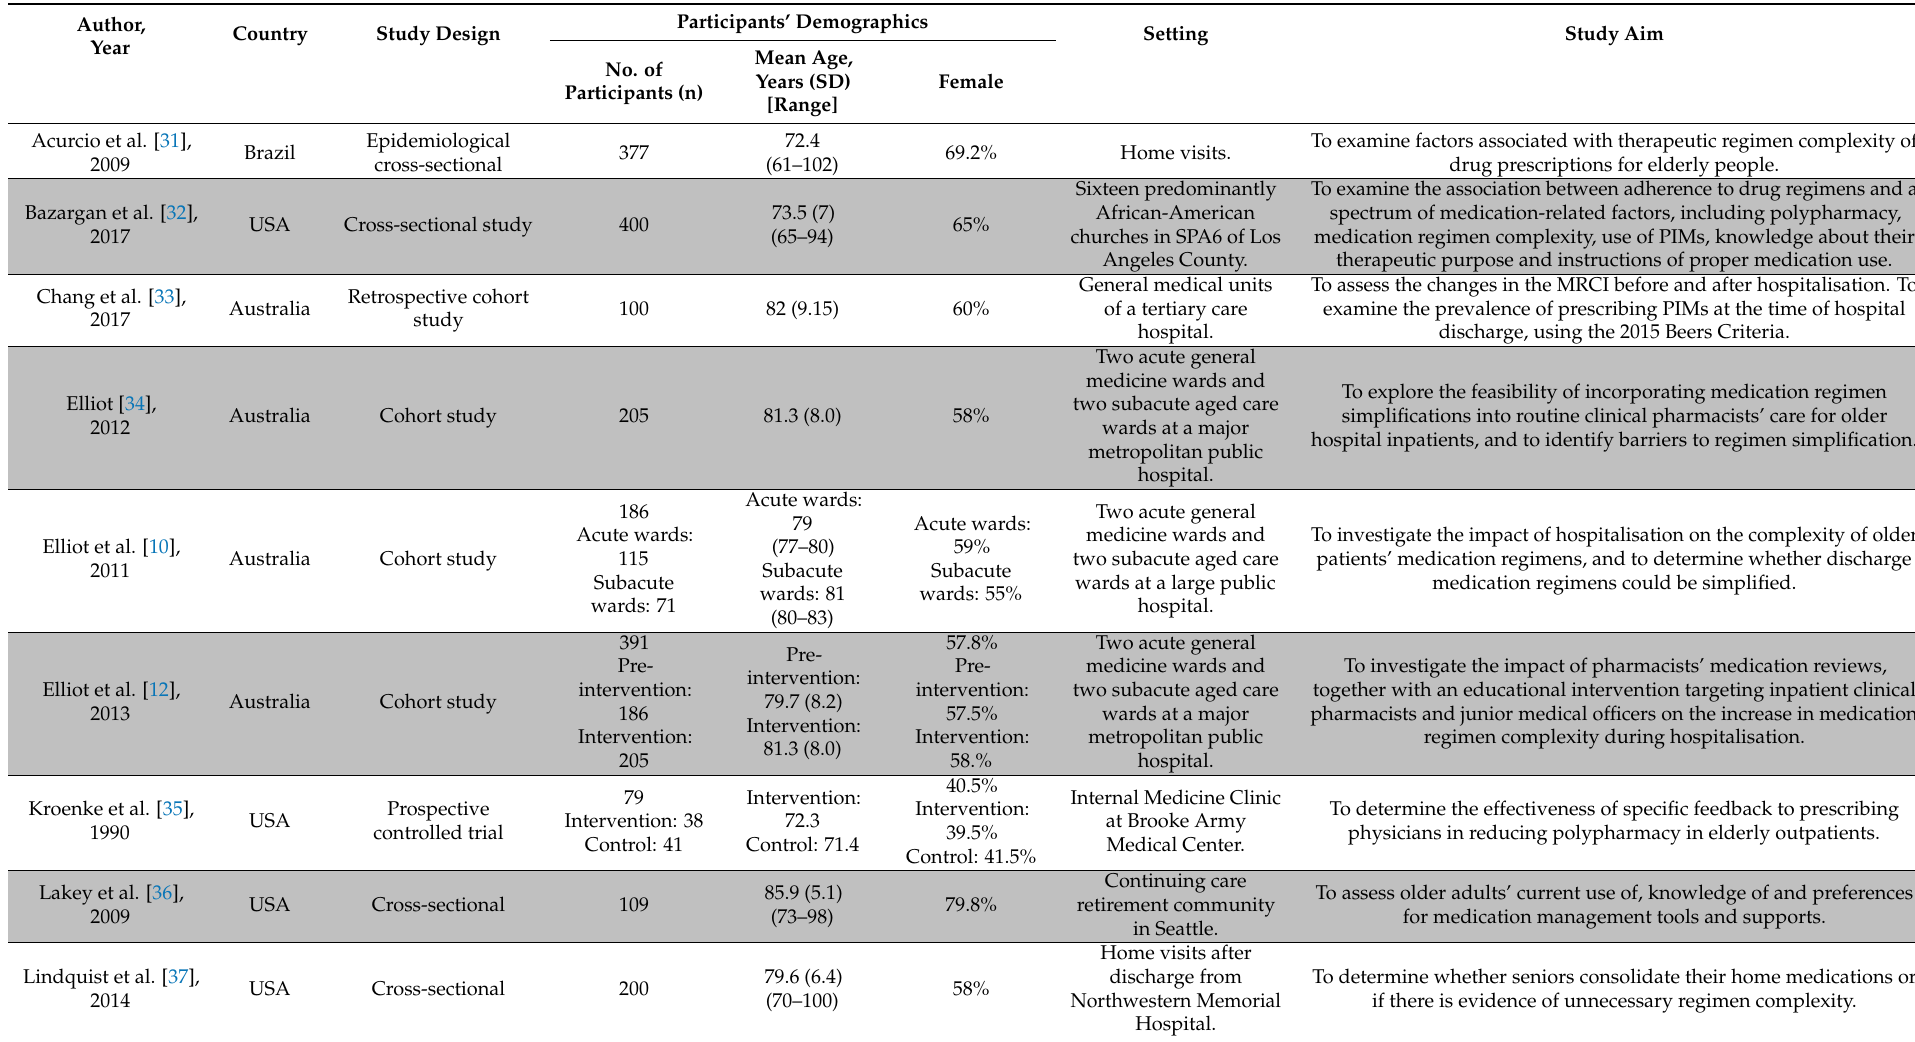
Table 1. Description of the included studies: country, study design, participants’ demographics, setting and study